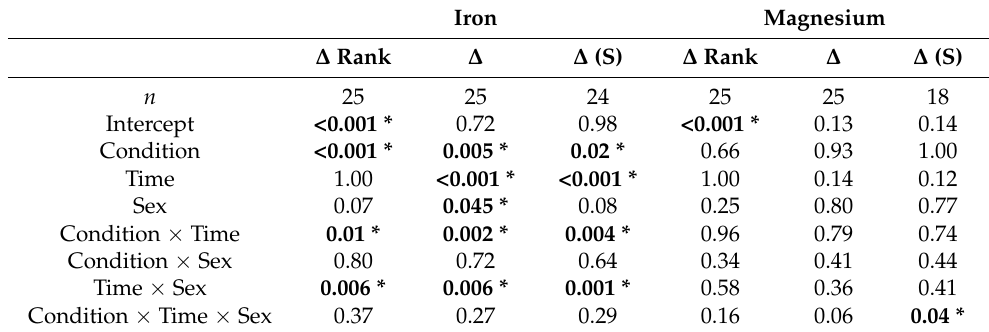
“ Δ Rank” indicates rank of percent change from baseline; “ Δ ” indicates percent change from base- line; “S” indicates sensitivity analysis results (removal of extreme outliers). “*” and bold text indi- cate statistical significance (i.e., p < 0.05).